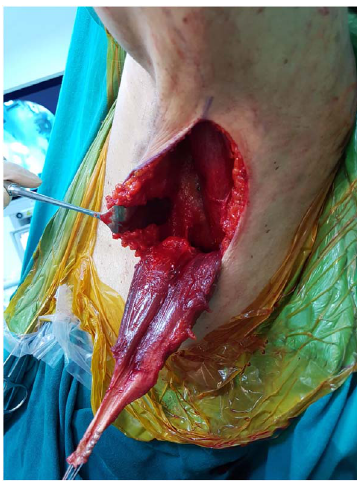
Figure 3. Preparation of the LD tendon by using axillary incision in a patient with massive rotator cuff tear.